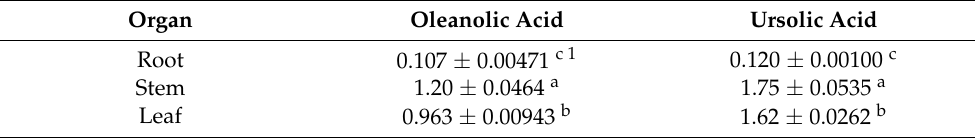
Table 1. The contents of oleanolic acid and ursolic acid detected in the roots, stems, and leaves of Lavandula pubescens (mg/g dry weight).